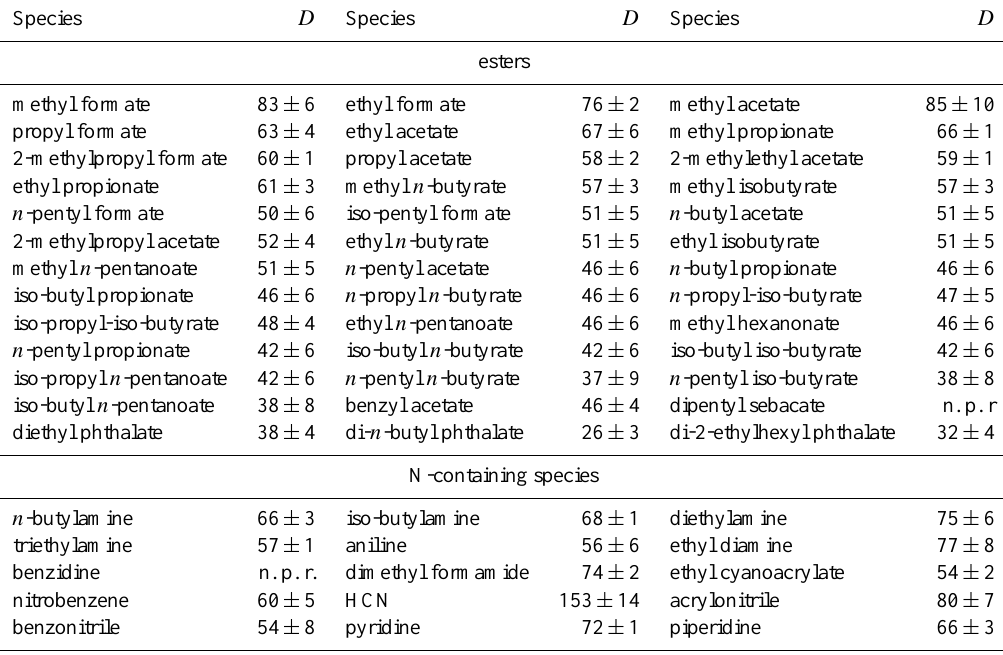
Table 3. Summary of preferred diffusivities ( D , Torrcm 2 s − 1 ) at 298K: esters and N-containing species. The uncertainties given to preferred values are explained in Sect. 3.